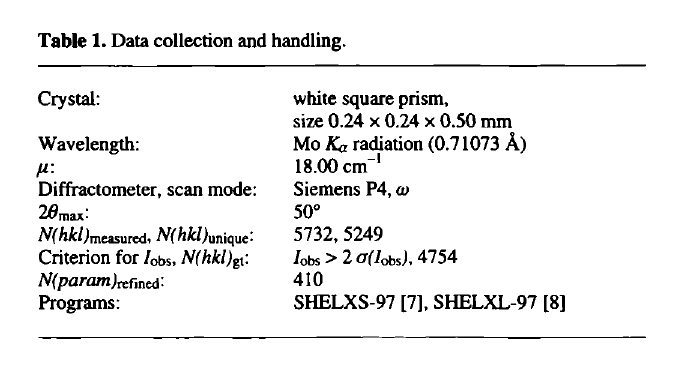
Table 1. Data collection and